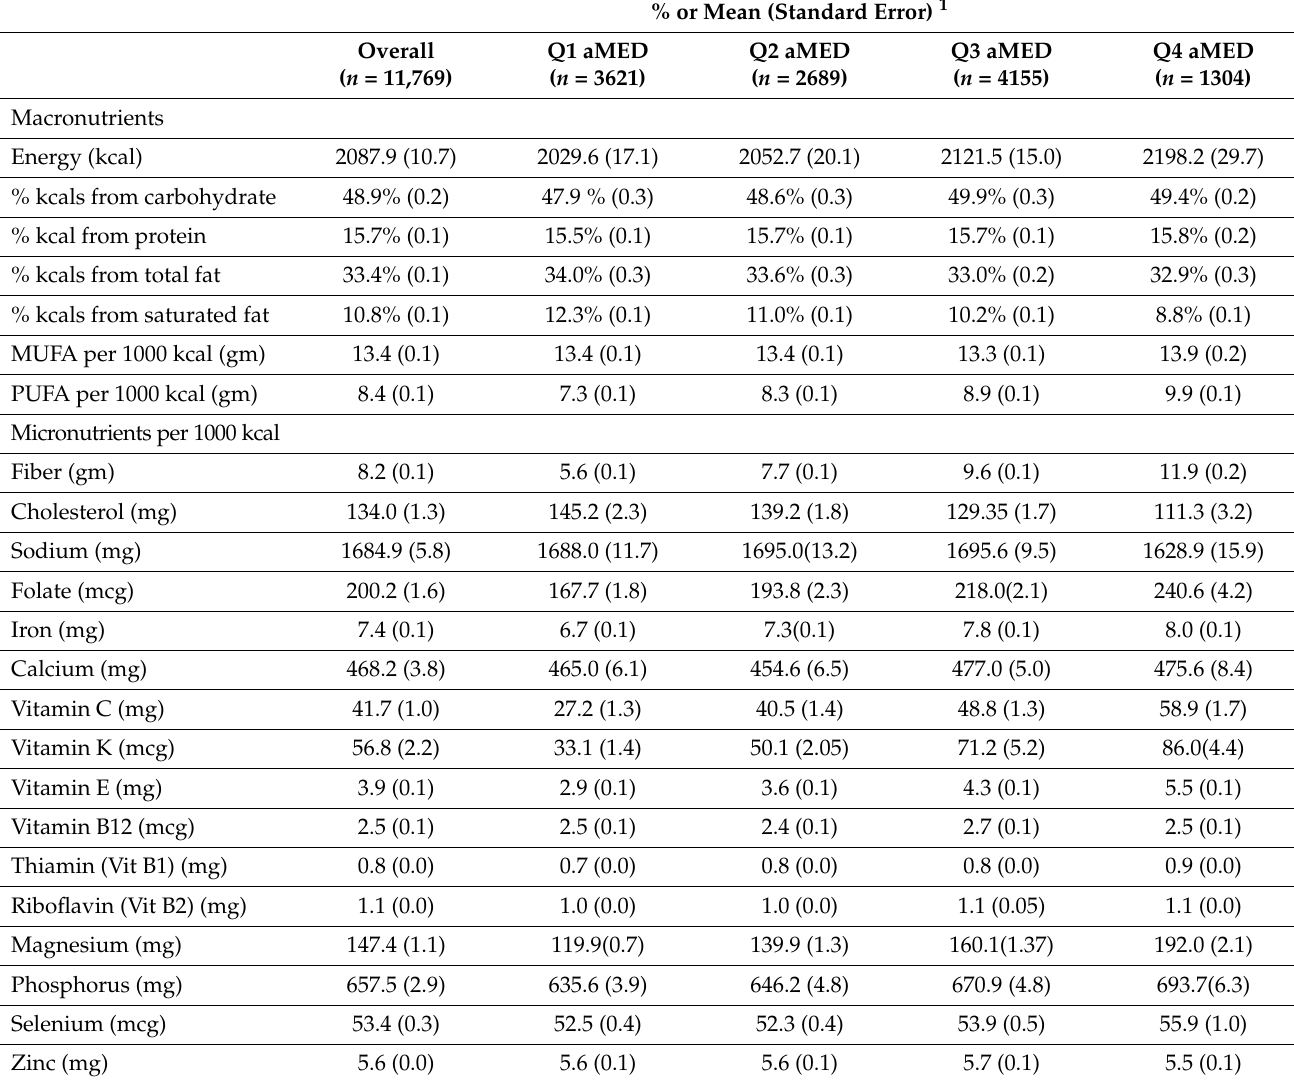
Table 2. Nutrient intake from one 24-h diet recall for adult men and women overall and by Alternate Mediterranean Diet score (aMED) quartile, NHANES 2007–2012. % or Mean (Standard Error)